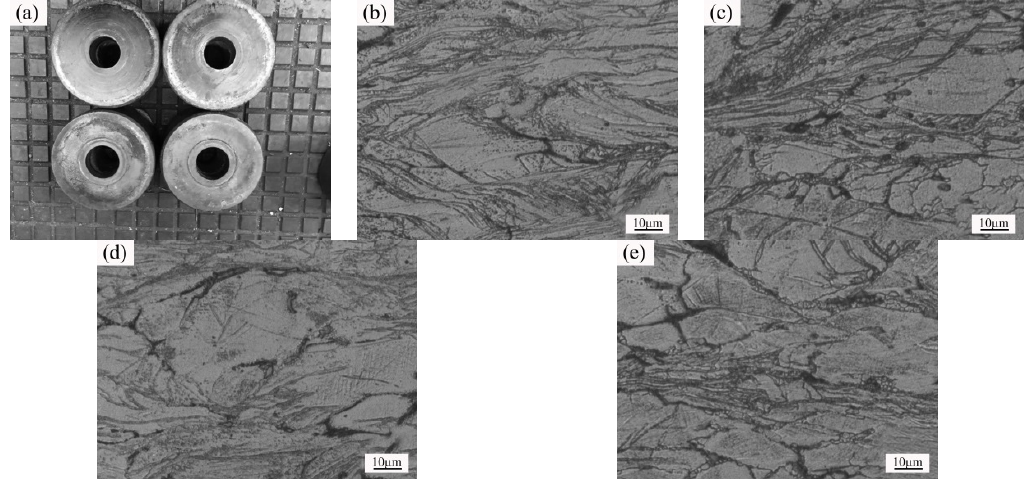
Figure 11. Picture and optical microstructure of the isothermal forging parts at different temperatures of: ( a ) Parts picture, ( b ) 320 °C, ( c ) 340 °C, ( d ) 360 °C, ( e ) 380 °C.